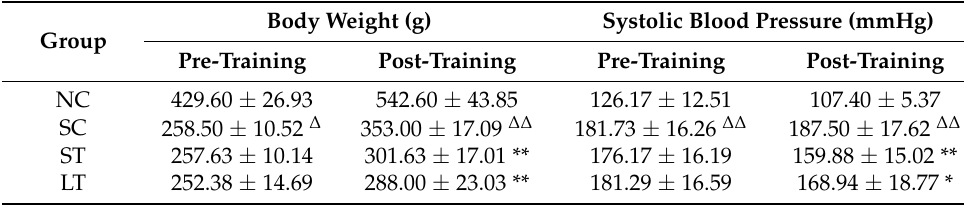
Table 1. Body weight and systolic blood pressure. Body Weight (g) Systolic Blood Pressure Group